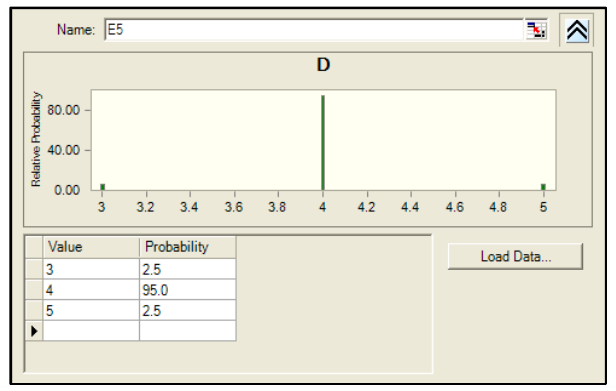
Figure 12. Case 1: Monte Carlo simulation of S in CB software.